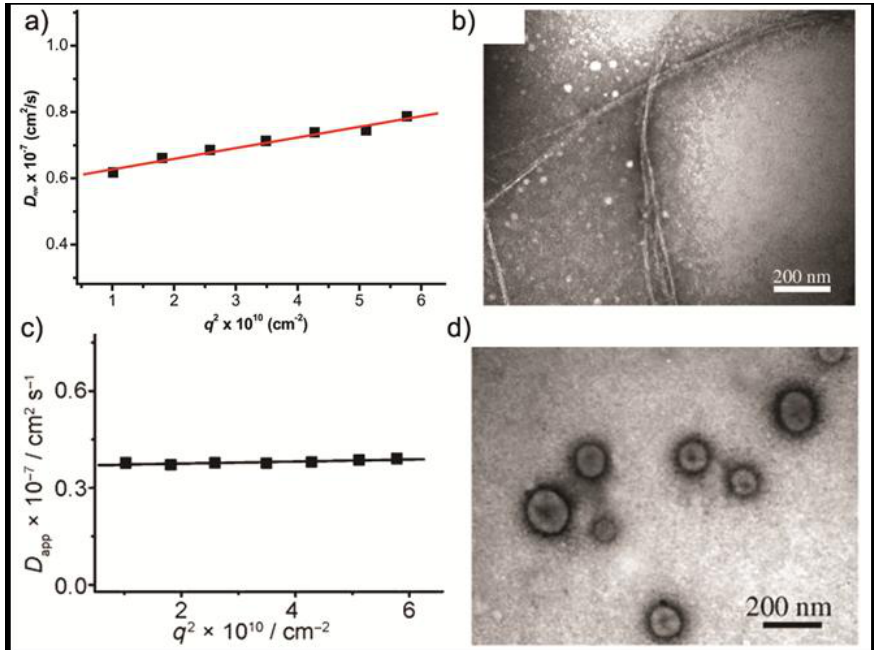
Figure 3. ( a ) Angular dependence ( q is the scattering vector) of the apparent diffusion coefficient, D , for the helical cylinders in aqueous solution ( C = 0.1 gL −1 ); ( b ) TEM app image of 5 with negative staining; ( c ) Angular dependence of D aggregates; ( d ) TEM image for the spherical capsules with negative staining. Reprinted with permission from [18]. Copyright 2006